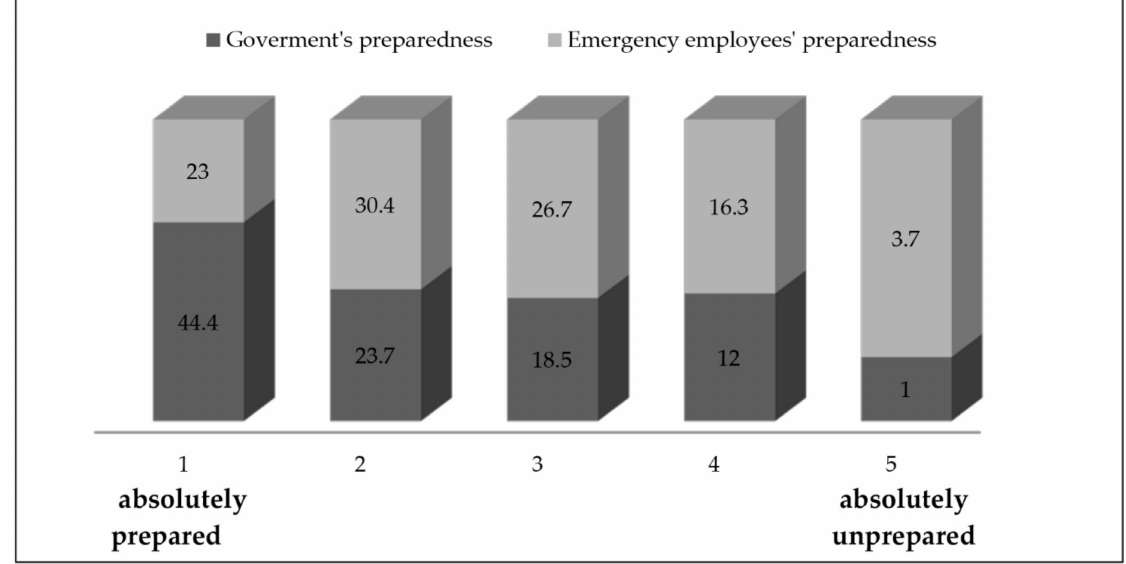
Figure 4. Public’s opinion of the government’s and emergency service personnel’s preparedness for nuclear (%) disasters.